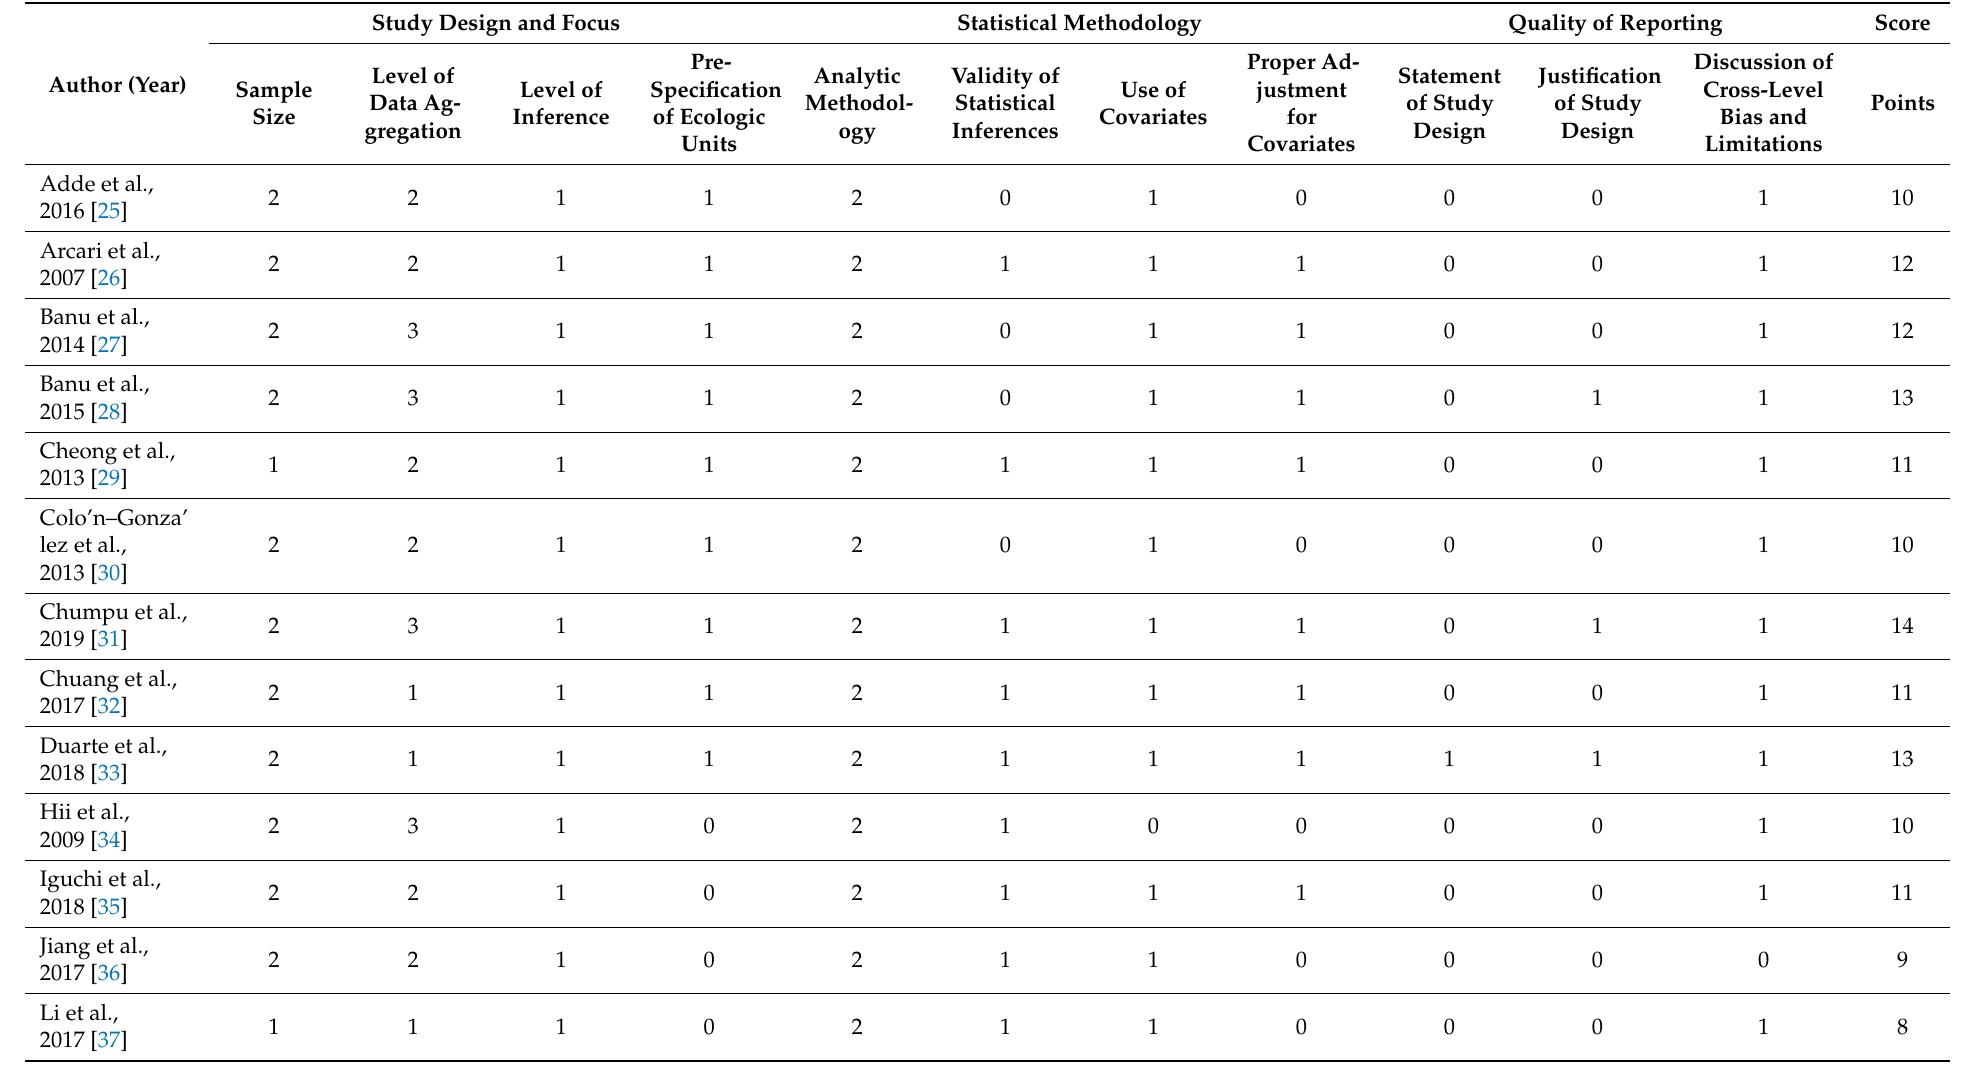
Table 4. Critical appraisal of selected studies. Modified scale from Dufault and Klar